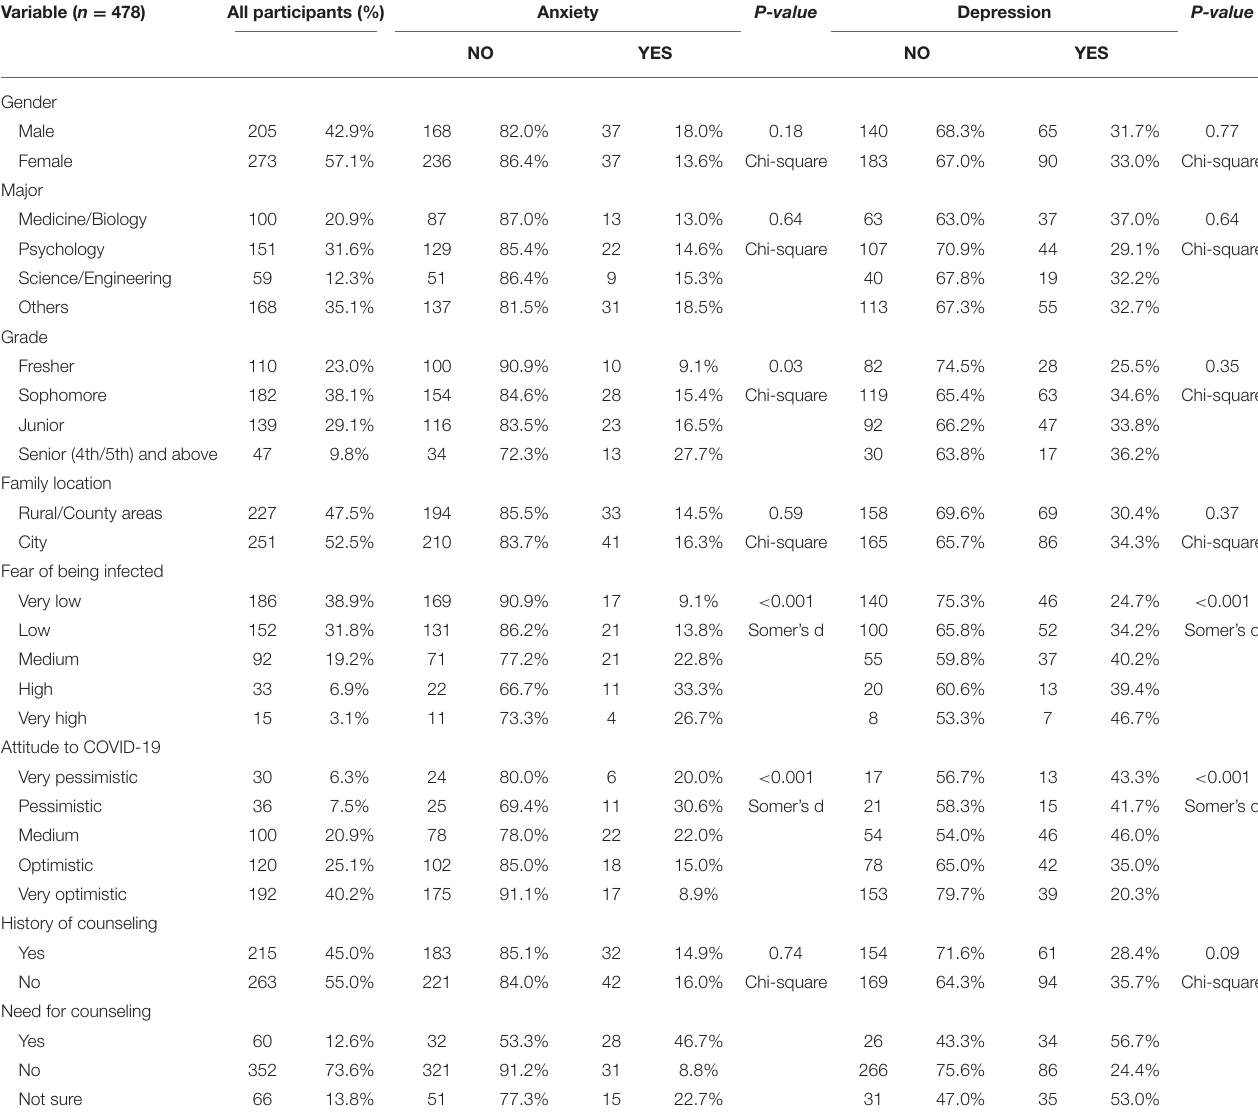
TABLE 1 | Descriptive analysis of basic